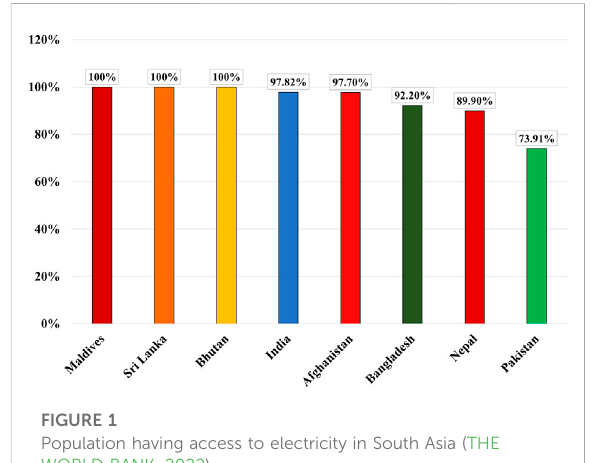
FIGURE 1 Population having access to electricity in South Asia (THE WORLD BANK, 2022). FIGURE 2